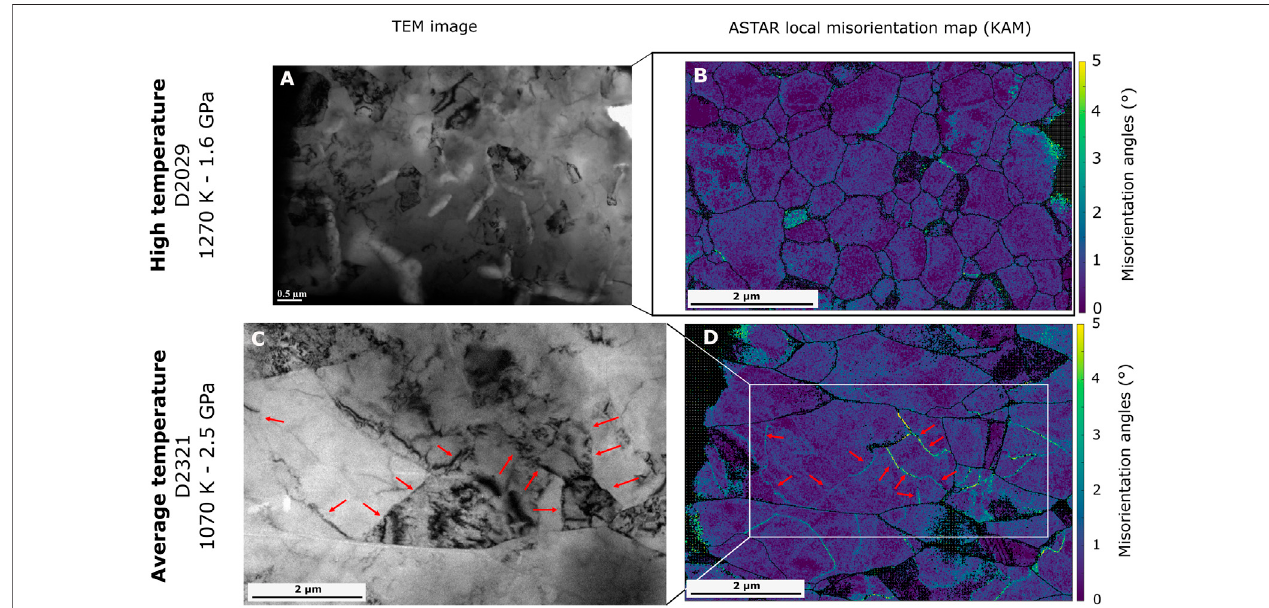
FIGURE11| Comparison ofmisorientation mapsacquired intheTEM (B,D) withclassical TEMimages (A,C) ofthesamesampleregion.Panels (A,B) illustrate the same section of sample D2029 using classical TEM imaging and ASTAR local misorientation gradients (KAM) mapping, respectively. Panels (C,D) illustrate the same area of sample D2321, by classical TEM imaging and ASTAR local misorientation gradients (KAM) mapping, respectively. Red arrows indicate accumulation of dislocationsintheclassicalTEMimageandthecorrespondingKAMlinesoftheTEMorientationmap.FullsizeASTARmapsareshownin SupplementaryFigures S13, S16